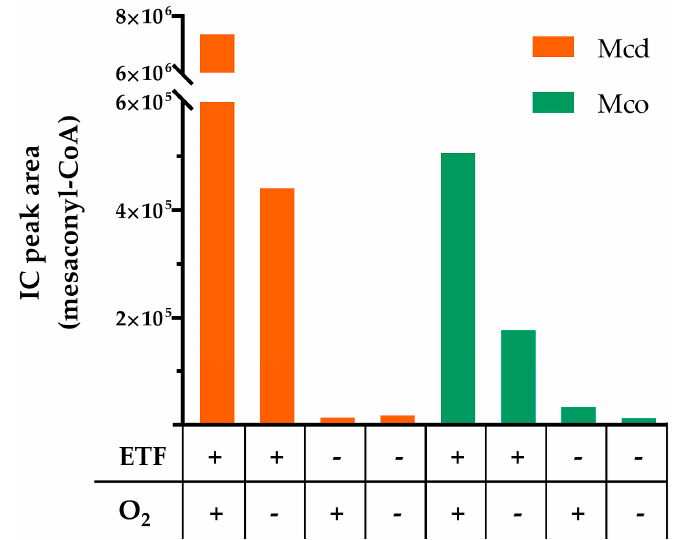
Figure 4. Representative analysis of product formation by Mcd and Mco after 1 h reaction time with ETF and/or O 2 . Assays were performed under aerobic (O 2 +) and anaerobic (O 2 − ) conditions, in the presence of ETF (ETF +) or its absence (ETF − ). Then, product formation was monitored by LC-MS. Reaction conditions: ETF 50 µM, air saturated solutions (235 µM O 2 at 30 °C). 0.05 µM enzyme, 250 µM (2 S )-methylsuccinyl-CoA.